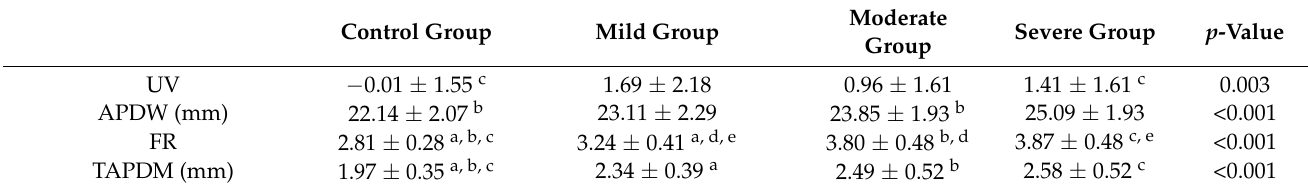
Table 6. Roentgenographic and ultrasonographic features in four severity